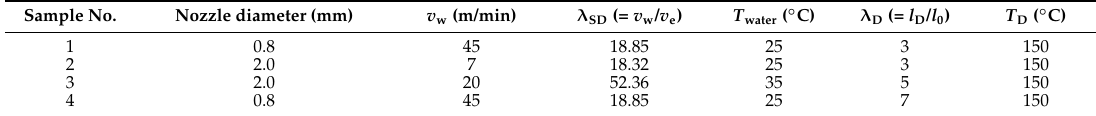
Table 1. Fiber processing conditions for the four POF samples selected for the SAXS analysis. Sample No. Sample